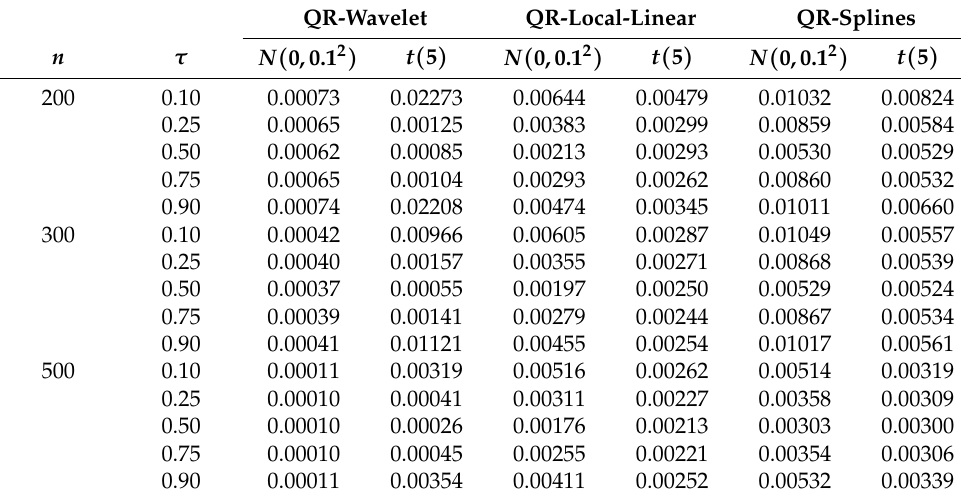
Table 1. MSEs of wavelet, local linear and spline smoothing in Case I: Pwpn.